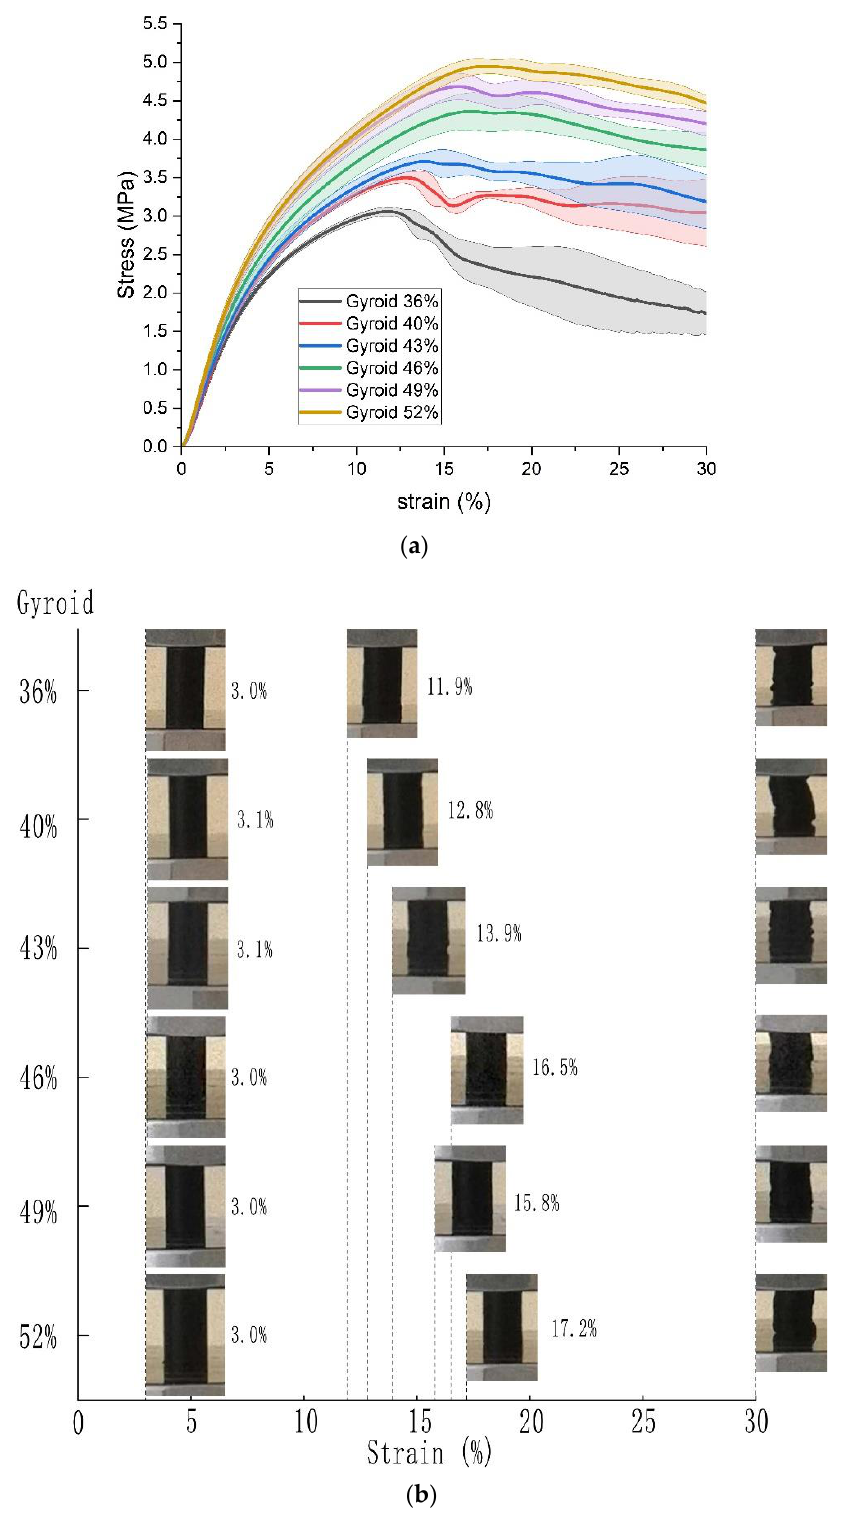
Figure 9. Results of Standard Specimens with gyroid fill. ( a ) stress versus strain; ( b )